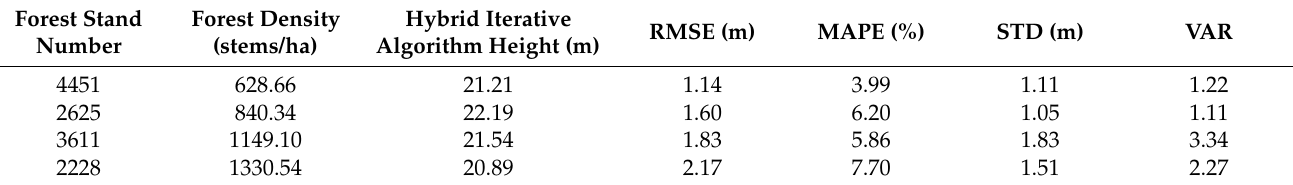
Table 5. Coherence magnitudes and three-stage hybrid iterative application model inversion out- comes for four realistic forest stands. The hybrid iterative algorithm height results from the coherence magnitude and three-stage hybrid iterative application model.